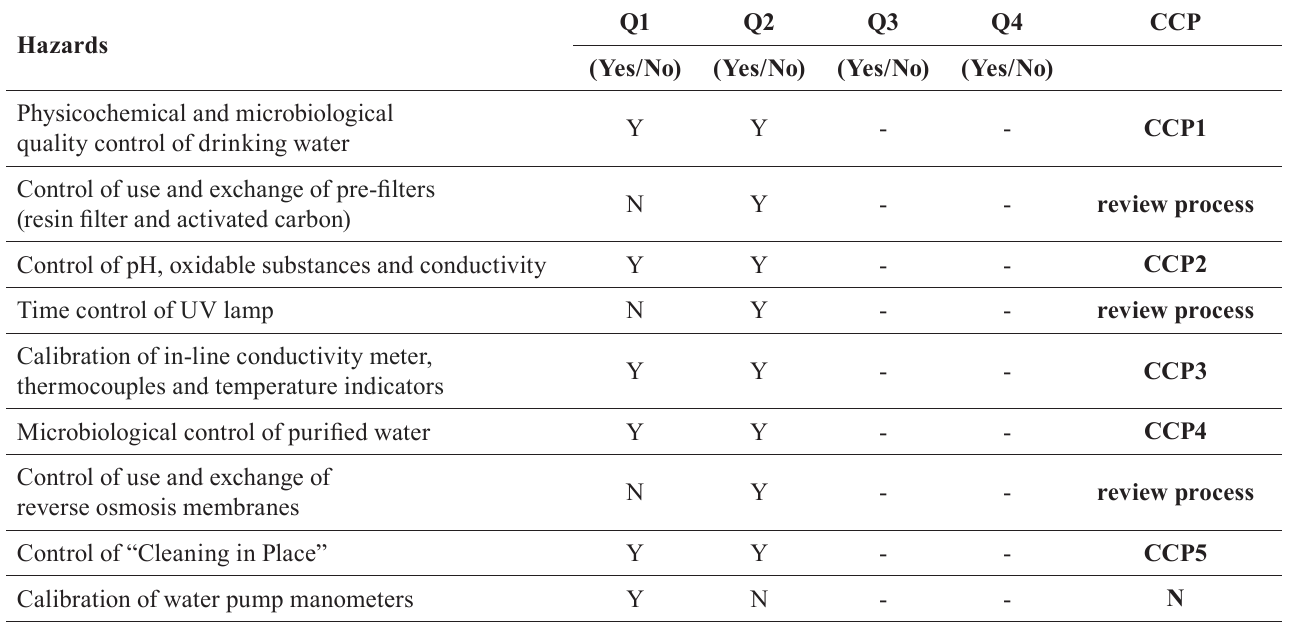
TABLE II - Decision tree of the HACCP plan used to determine CCPs for the analyzed water purification system Hazards